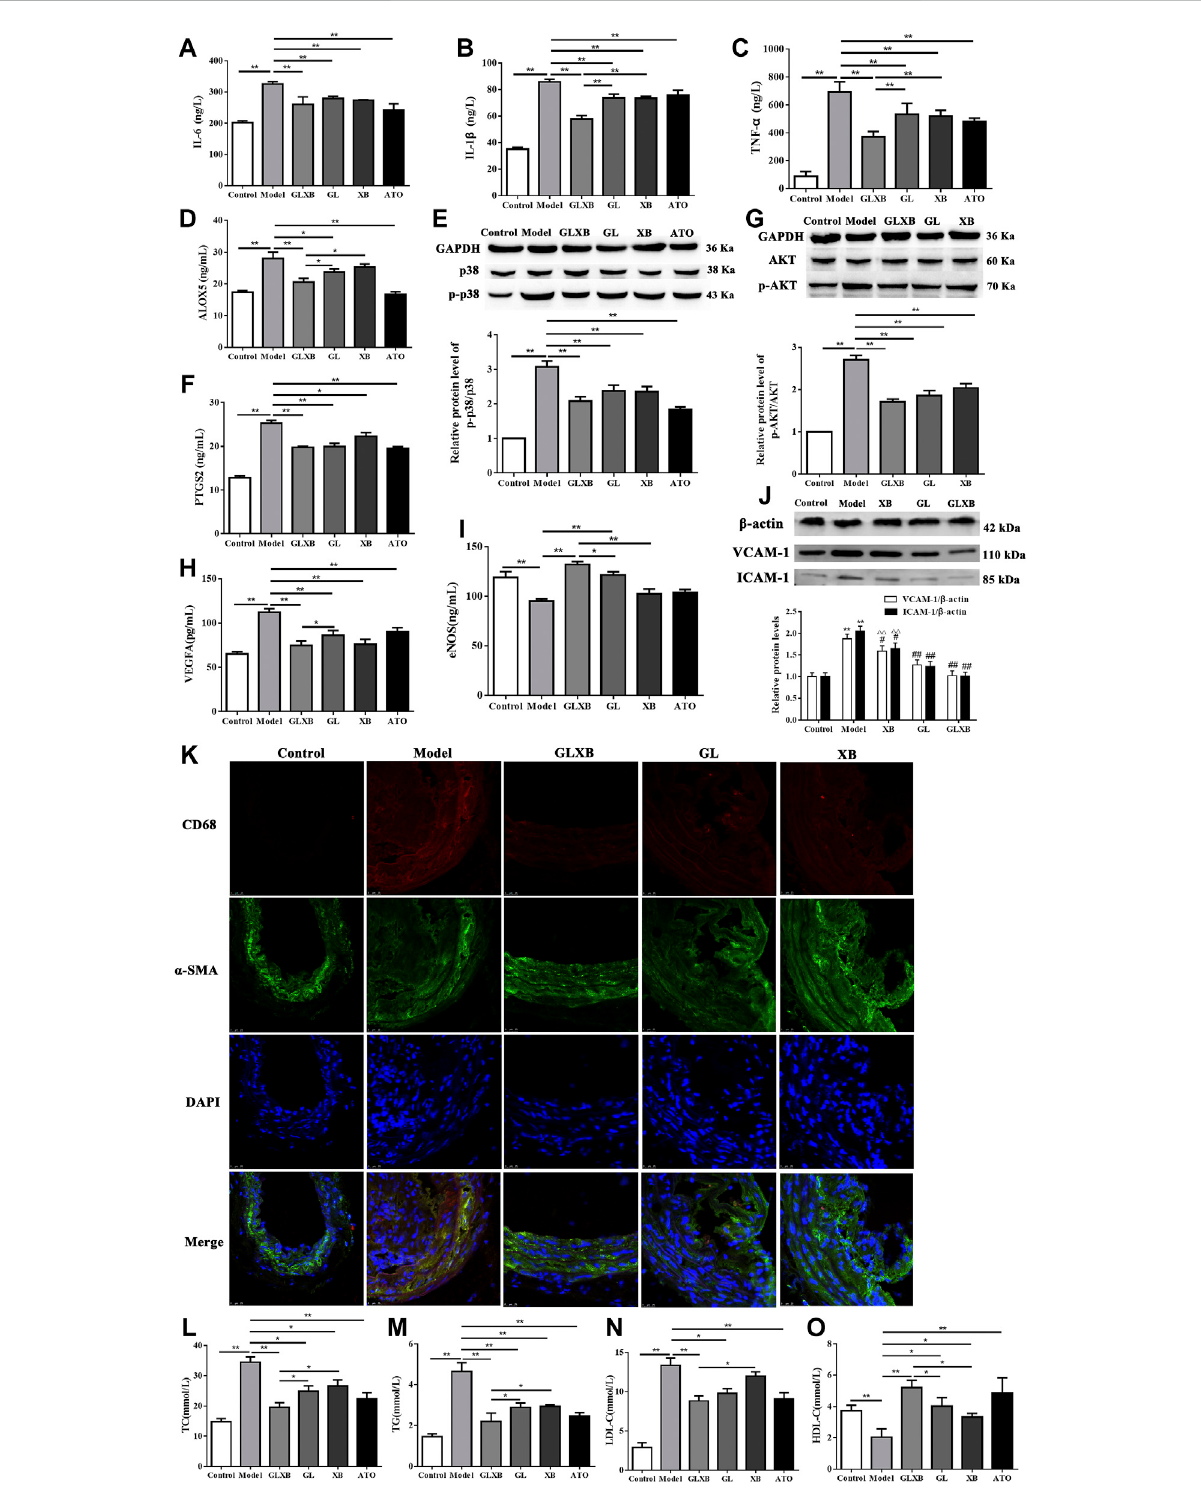
FIGURE 7 Validation of the mechanismsof GLXB treatment against AS in vivo. (A) The level of IL-6 in the serum of mice. (B) The level of IL-1 β in the serum ofmice. (C) ThelevelofTNF- α intheserumofmice. (D) ThelevelofALOX5intheserumofmice. (E) Theexpressionofthep-p38 proteinintheaorta ofmice. (F) ThelevelofPTGS2intheserumofmice. (G) Theexpressionofthep-AKTproteinintheaortaofmice. (H) ThelevelofVEGFAintheserum of mice. (I) The level of eNOS in the serum of mice. Data were expressed as mean ± SEM. * p < 0.05, ** p < 0.01. (J) The expressions of VCAM-1